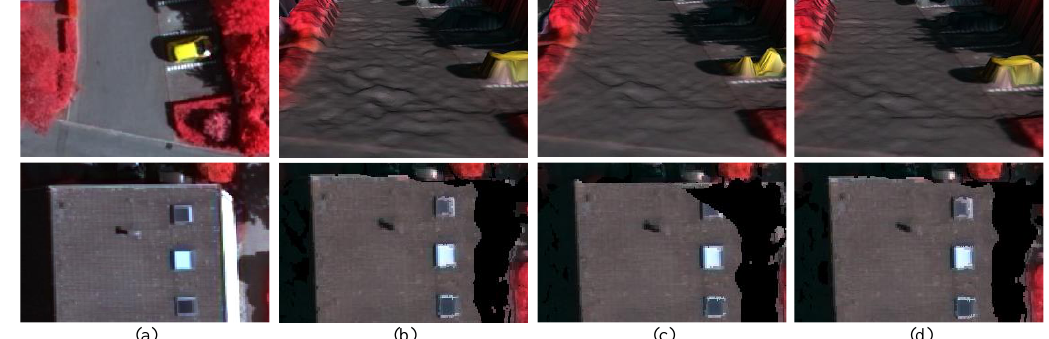
Figure 6. Matching results of Vaihingen dataset. a) enlarged images, b) results of small parameters ( P 1 =28 and P 2 =70 ), c) results of larger parameters ( P 1 =56 and P 2 =140 ), and d) results of the adaptive parameter selection. The top row shows textureless areas from the blue rectangles in Figure 5 and the bottom row shows geometric discontinuities from the red rectangles.